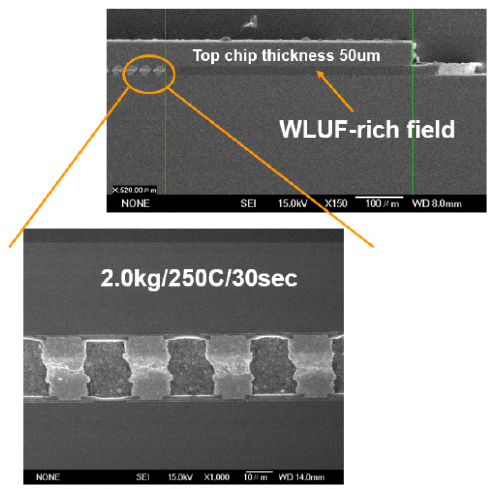
Figure 1. Cross-sectional view of microbump interconnects with WULF assembled through thermal